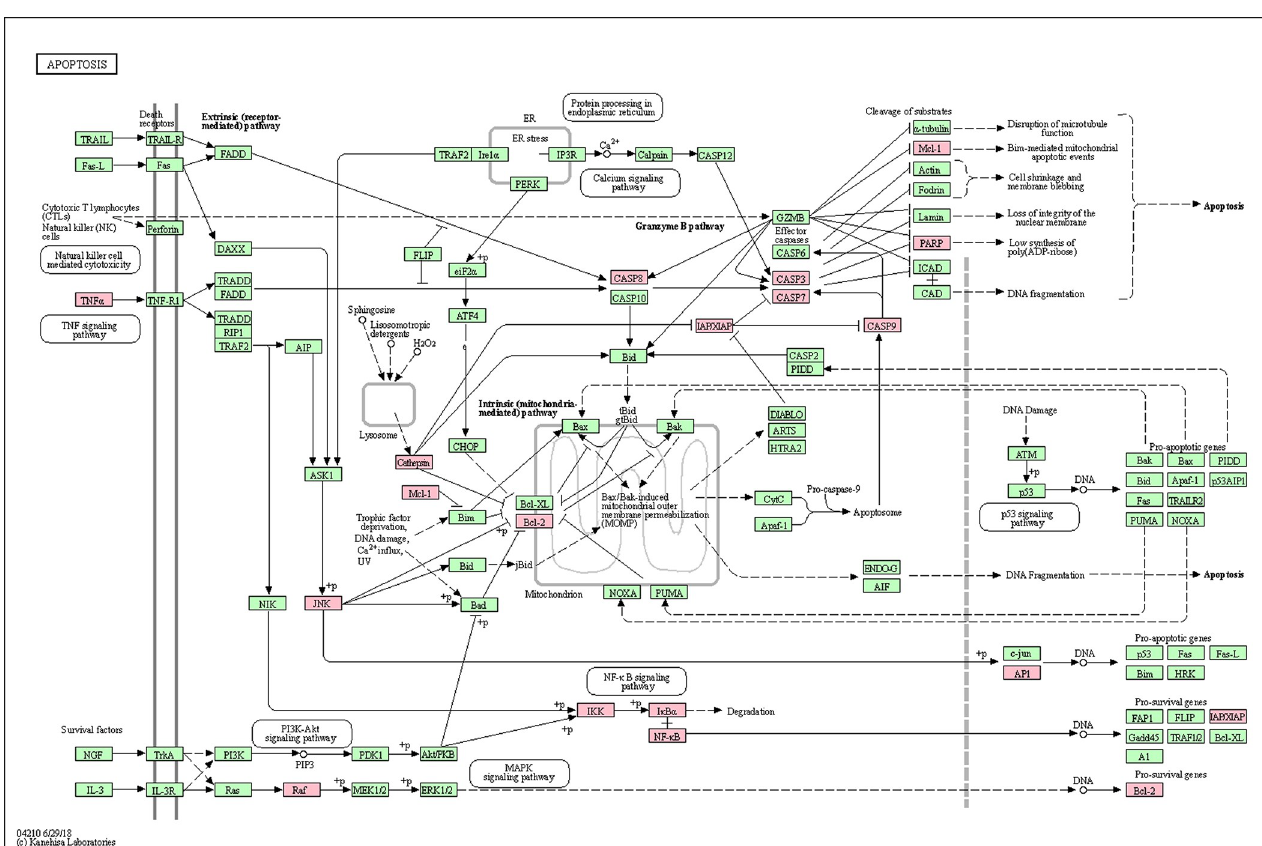
Fig 10. Apoptosis signaling pathway. The red rectangle represents the targets related to the core component-target-pathway network.